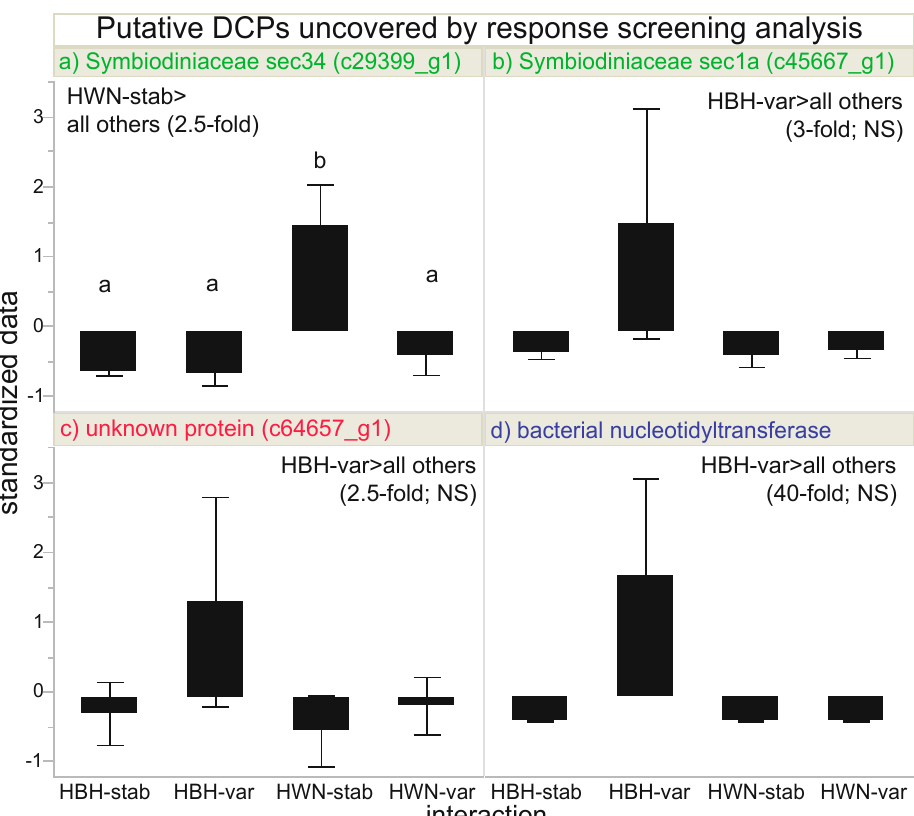
Figure 3. “Most di ff erentially concentrated” proteins. Four proteins were identified by response screening analysis to be potentially di ff erentially concentrated across the interaction of site (Houbihu [HBH] vs. Houwan [HWN]) and temperature regime (variable [var] vs. stable [stab]) at a false discovery rate-adjusted p -value of 0.01, and lowercase letters above standardized data in panel ( a ) represent significance (Tukey’s HSD post-hoc tests of box-cox-transformed data, p < 0.05). Error bars represent standard deviation ( n = 2–4 per interaction group). Note that there were no pairwise di ff erences for sec1a ( b ; box-cox-transformed data), the unknown protein c64657_g1 ( c ; log-transformed data), or the bacterial nucleotidyltransferase ( d ; non-parametric 2-way ANOVA). NS = not